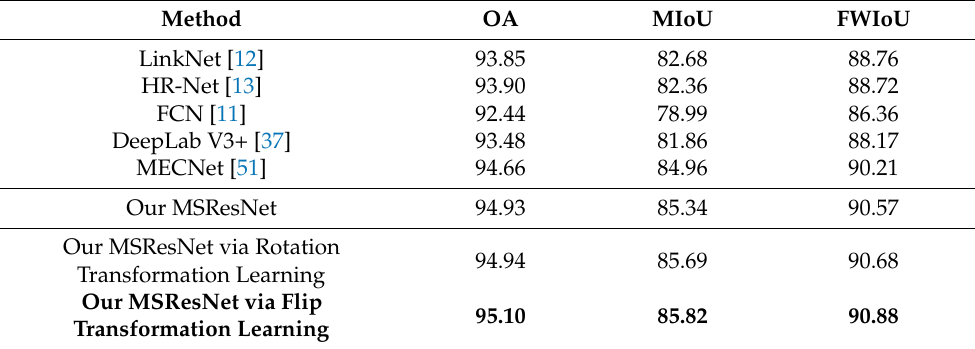
Table 3. Performances for the 2020 Gaofen Challenge water-body segmentation dataset